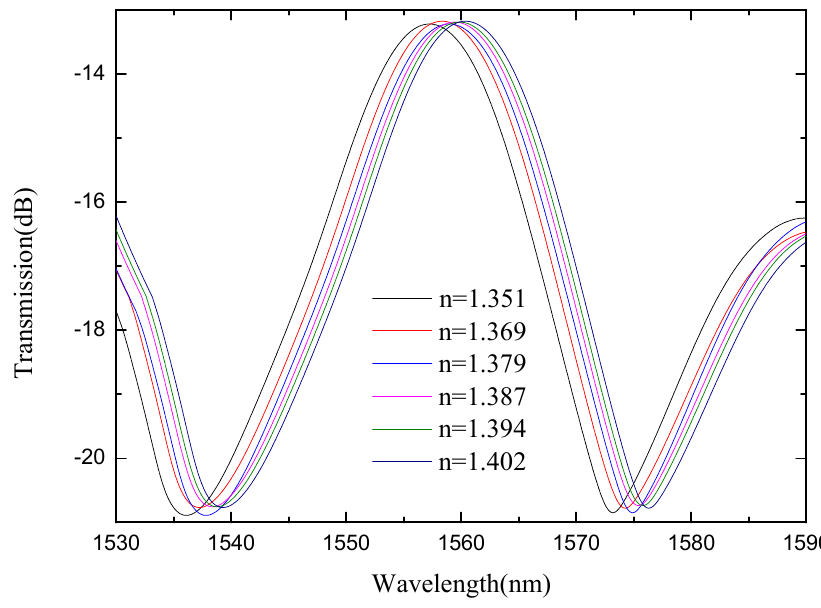
Figure 14. Spectra of SMBMS MZI(1/2L) at different refractive indices.